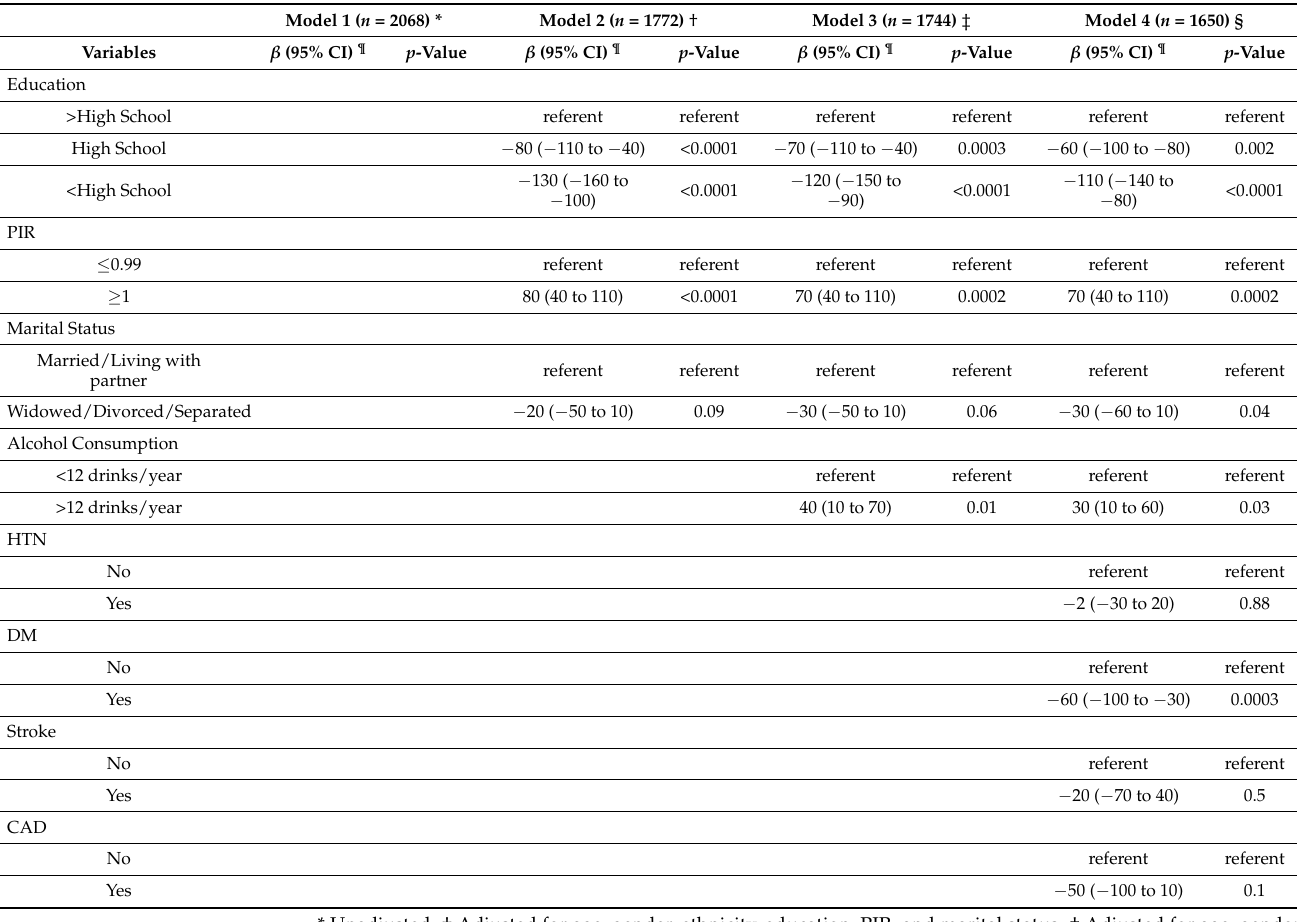
CAD. ¶ Weighted β and 95% Confidence Interval.